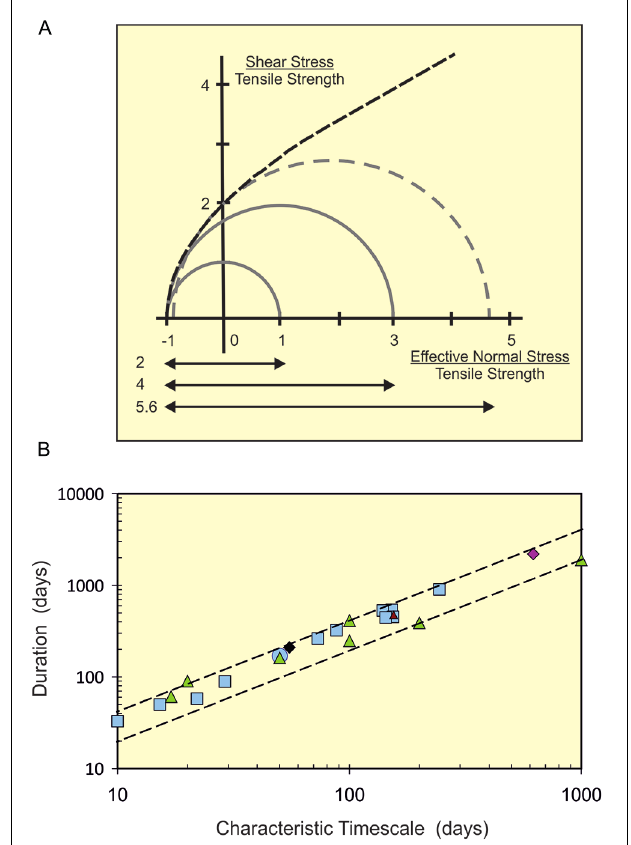
FIGURE 6 | (A) The Mohr–Coulomb–Griffith representation of bulk failure in terms of applied normal and shear stresses. The outer dashed curve shows the parabolic form of the failure envelope [for mathematical treatments, see Secor (1965); Shaw (1980), and Sibson (1998)]. The Mohr circles ( continuous and dashed semi-circles ) describe states of stress between the maximum and minimum effective normal stresses; positive values are in compression, negative values in tension. The diameter of a circle gives the applied differential stress, S . Failure occurs when the minimum normal stress meets the failure envelope. Tensile failure corresponds to where the circles meet the envelope at zero shear stress (hence intersect the horizontal axis) and the minimum effective normal stress equals the tensile strength (with a normalized value of –1). To satisfy this condition, the Mohr circle must have a diameter less than or equal to 4 σ T (or normalized diameter of four; arrows beneath graph ) The maximum value ( larger continuous semi-circle ) may represent the opening of a failure plane. For comparison, failure at the margins of a long vertical cylinder is shown with a normalized diameter of two ( smaller continuous semi-circle ). The dashed semi-circle (normalized diameter of 5.6) shows the Mohr circle at the transition between failure in extensional (tension and shear) and compression (shearing alone). (B) Values of T / t ch for quasi-elastic pre-eruptive behavior at Etna, Sicily ( blue squares ; Wall, 2014), Kilauea, Hawaii ( green triangles ; Bell and Kilburn, 2011), Mauna Loa, Hawaii ( magenta diamond ; Lengliné et al., 2008), Piton de La Fournaise, Réunion ( small dark red triangle ; Lengliné et